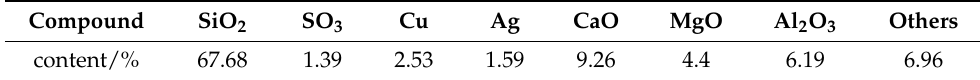
Table 1. Mineral composition of tailings.